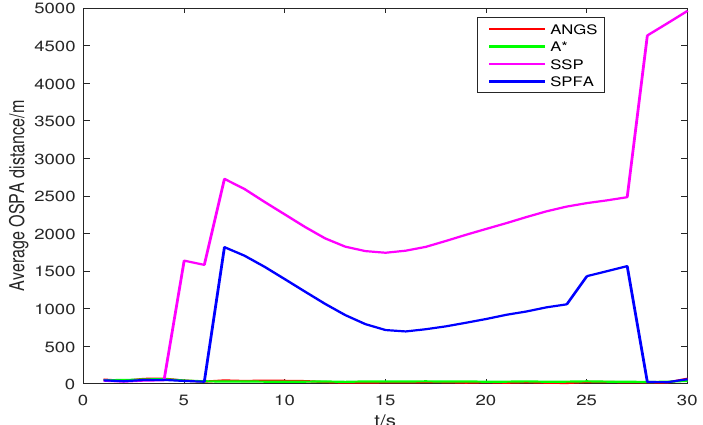
Figure 8. The average OSPA distance in scenario 2, with c = 10 and p = 2.